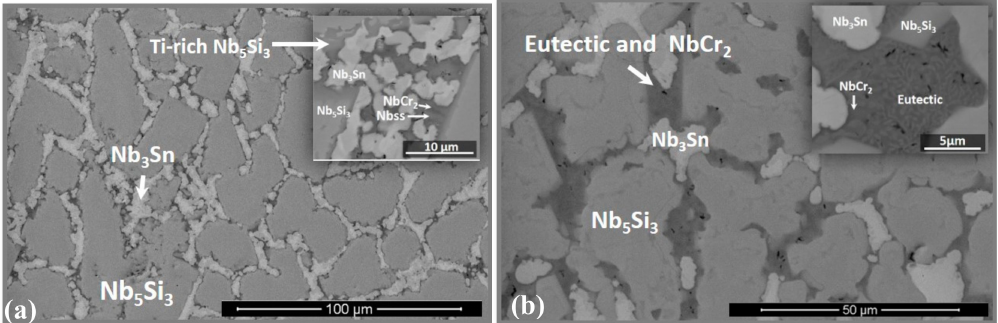
Figure 1. Back-scattered electron (BSE) images of the microstructure of OHS1-AC (as-cast): ( a ) bulk and ( b ) bottom.